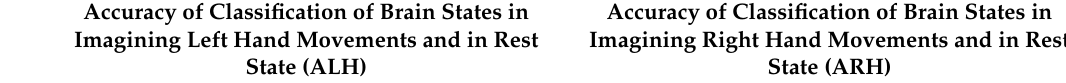
Table 3. Correlations between personality traits and the accuracy of classification of brain states during imagination of hand movements (of the left hand (LH) or of the right hand (RH)) comparative to the rest taking into account latent handedness. Accuracy of Classification of Brain States in Accuracy of Classification of Brain States in Imagining Right Hand Movements and in Rest Imagining Left Hand Movements and in Rest Personality Trait State (ARH) State (ALH) (Cattell) PCC NCC PCC NCC All +0.346 * All +0.304 * Liveliness (F)